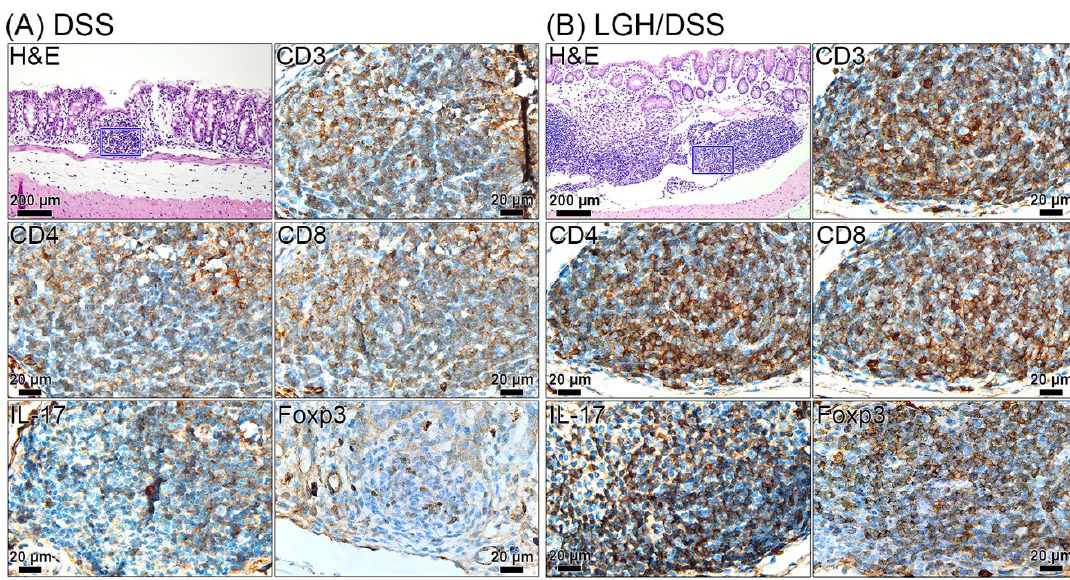
Figure 6. Representative immunohistochemical staining for the expression of CD3, CD4, CD8, IL-17, and Foxp3 in the lymphoid aggregates in colons of different groups. ( A ) DSS and ( B ) LGH/DSS. Representative images from serial tissue sections showed the target protein in the same region of lymphoid aggregates (inset, indicated by blue square in H&E staining sections of ( A ) and ( B ); scale bar, 200 μm). Each inset represented the target protein (CD3, CD4, CD8, IL-17, and Foxp3) at higher magnification (scale bar, 20 μm). DSS, dextran sodium sulfate; LGH, longish glucomannan hydrolysates.